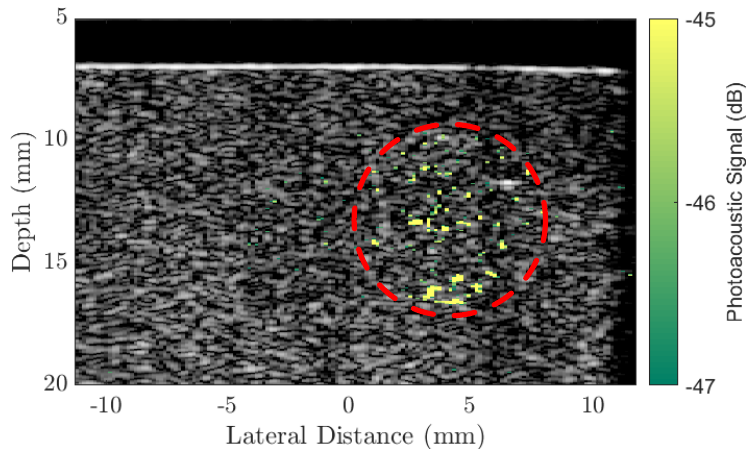
Figure 2. A conventional B-mode plane-wave image (9 compounding angles) of a tissue-mimicking agar phantom with an overlaid photoacoustic image generated by a 8mm diameter inclusion of Au50 AuNRs (concentration 20 µ g/mL) at a depth of 3mm below the surface and a laser fluence = 19 ± 2mJ/cm 2 at the surface. The PA signal is referenced to the maximum of the B-mode image (dB). Red circle indicates the region of